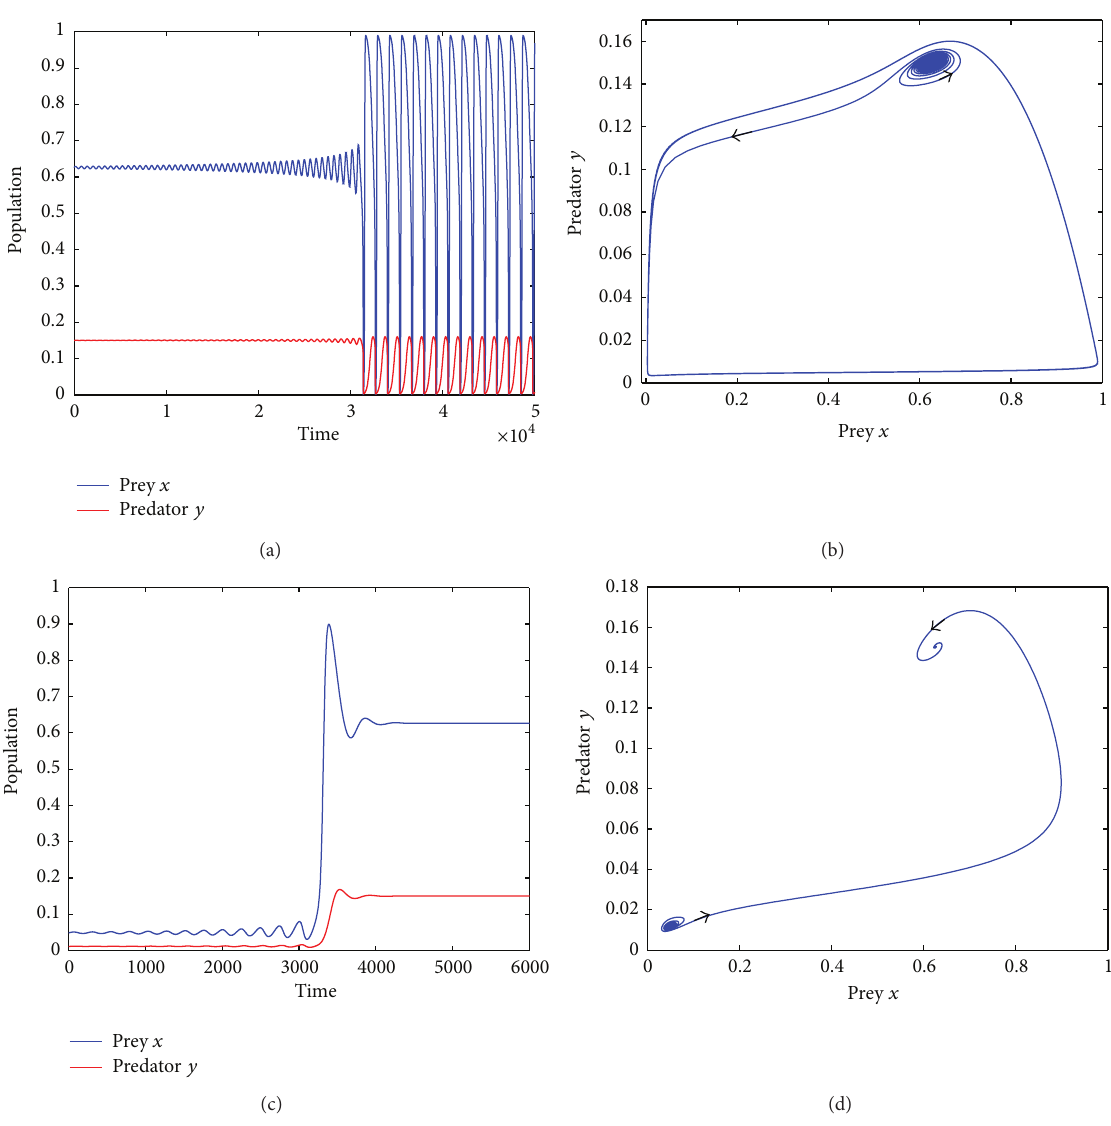
𝐸 ∗ 1 and 2 are unstable and the positive equilibrium